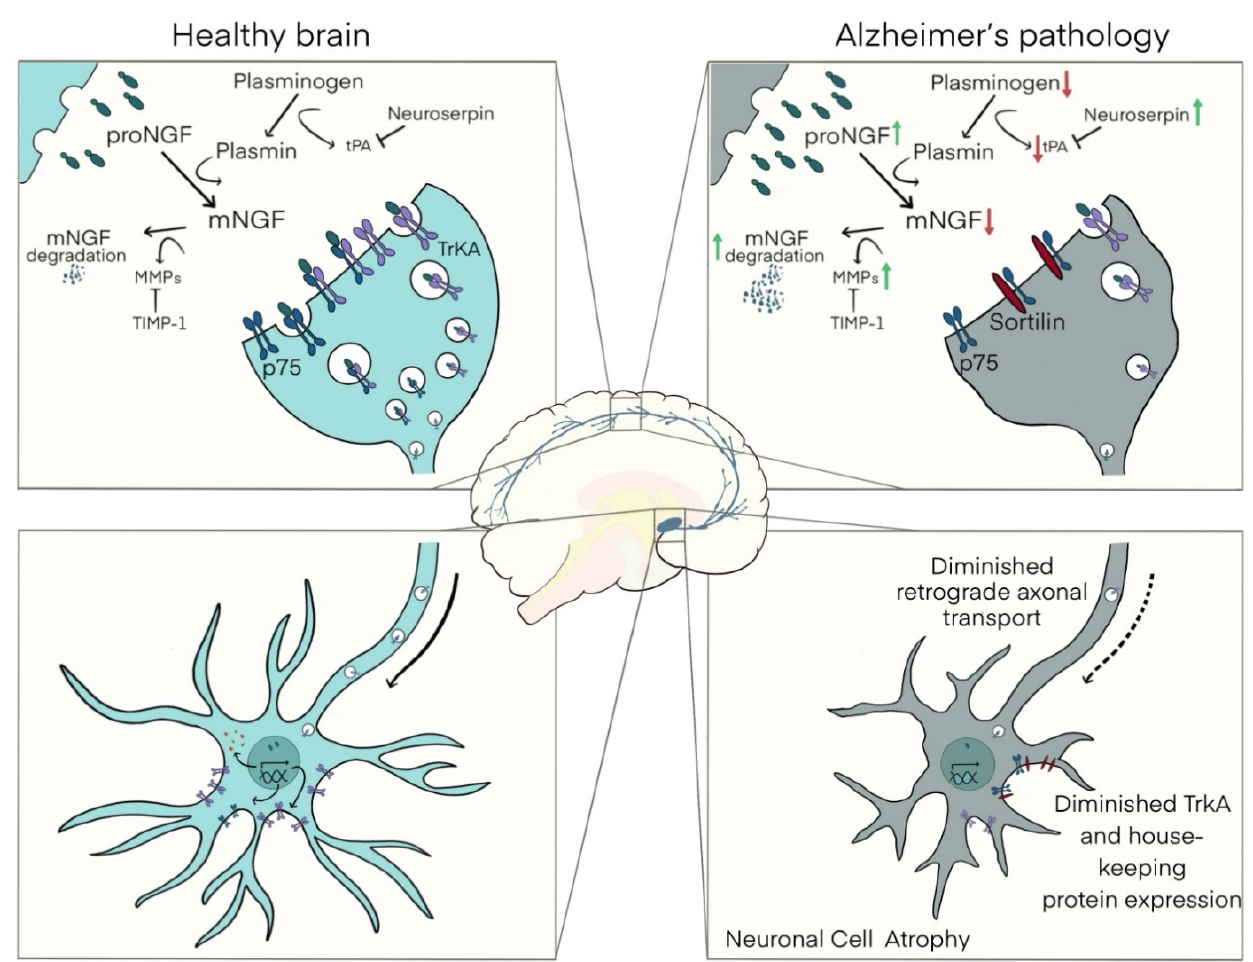
Figure 1. The NGF pathway and its dysregulation in Alzheimer’s and Down syndrome pathology. In the healthy brain ( left ), upon neuronal stimulation, proNGF is secreted into the synaptic cleft along with the zymogens and convertases involved in its maturation and degradation. proNGF is converted to mNGF by plasmin, itself produced from the cleavage of plasminogen by tPA, under the control of neuroserpin. mNGF then dimerizes and binds to p75/TrkA receptor complexes on presynaptic terminals of BFCNs, to be internalized and retrogradely transported to their neuronal soma in the basal forebrain to fulfill its trophic functions. These include the control of the expression of housekeeping proteins, transcription factors, ribosomal proteins, and cytoskeletal proteins responsible for axonal transport. Receptor-unbound mNGF is rapidly degraded by metalloproteinases, produced under the control of TIMP-1. In the brain of individuals with Alzheimer’s pathology ( right ), including those with Down syndrome, increased neuroserpin and decreased tPA limit the conversion of plasminogen into plasmin. As plasmin is responsible for the maturation of proNGF to mNGF, this results in a build-up of proNGF. In parallel, increased MMP-9 and MMP-3 and decreased TIMP-1, their natural inhibitor, resulted in the excessive degradation of free, receptor-unbound mNGF. This two-pronged attack on the NGF metabolic cascade, driven by AD pathology, leads to a substantial decrease in mNGF bioavailability, and thus a substantial decrease in the trophic support of BFCNs, leading to their atrophy. Arrows indicate the direction of the alterations for each important member of the NGF pathway. Red represents a reduction in the protein levels and green an elevation.